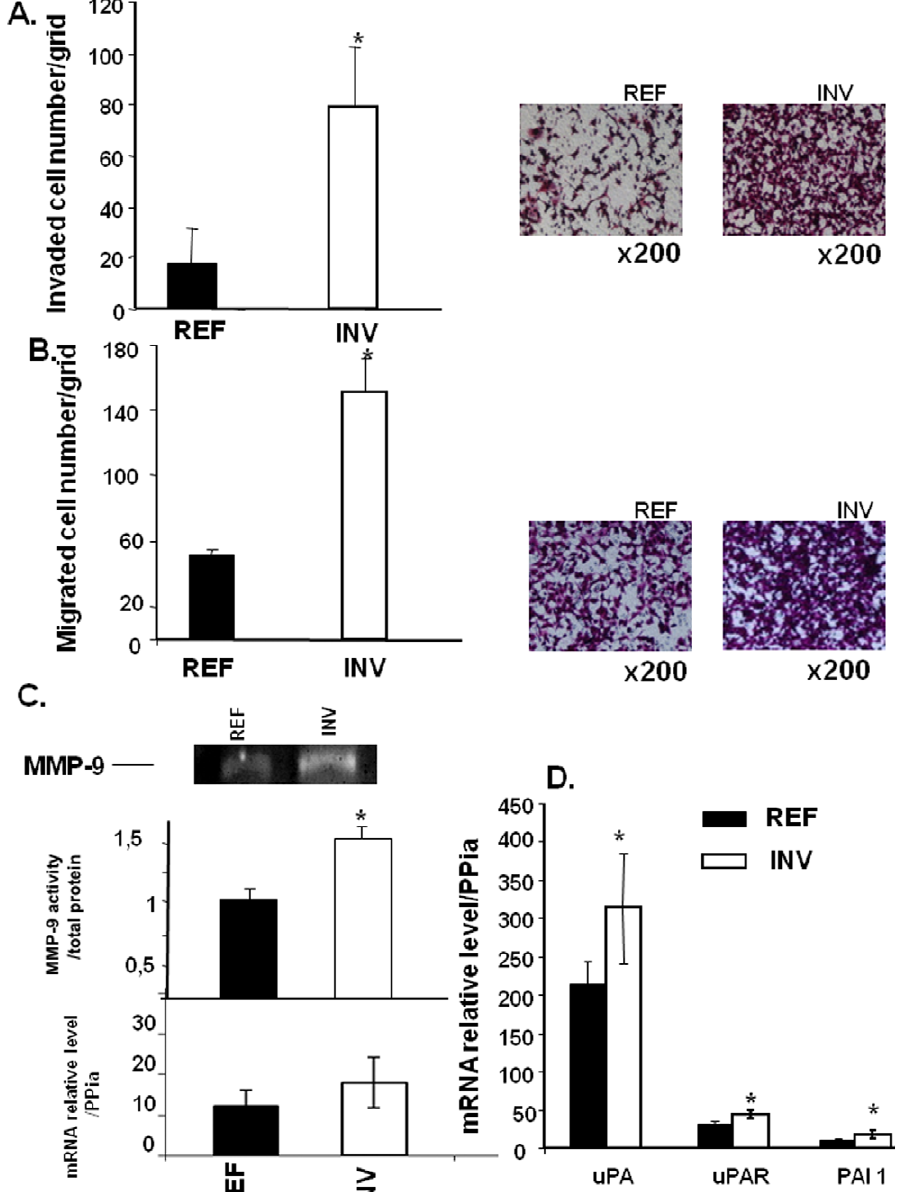
Figure 1. INV and REF breast cancer cell invasion and migration. Cells (2.5 6 10 5 ) were added to the upper side of each 8 m m insert of Boyden chambers coated (A) or not (B) with Matrigel for invasion or migration assays respectively; cells were then counted as described in Materials and Methods. MMP-9 activity secreted by REF (lane 1) and INV (lane 2) cells (C) was assessed by subjecting aliquots of lyophilized conditioned media normalized to the number of cells to 10% SDS-polyacrylamide gels containing 1 mg/mL gelatin. For QRT-PCR analysis (D), total RNA (1 m g) was reverse-transcribed using MMLV RT and subjected to qRT-PCR as described in Material and Methods. Representative data was normalised to PPIA is given. Each column represents a mean ( 6 SD) of three independent experiments. * P , 0.05.